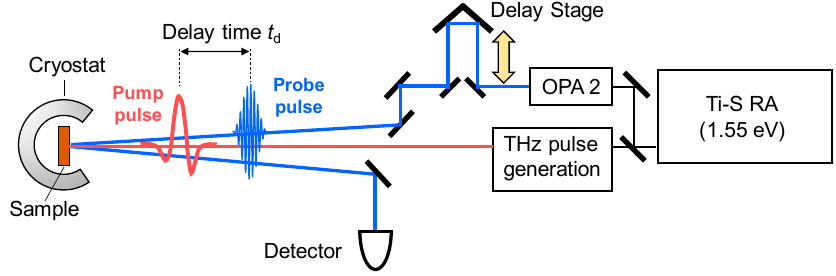
Figure 10. Schematic of terahertz-pump optical-reflectivity-probe measurement system. A terahertz-pump pulse is generated by a pulse-front-tilting method in a LiNbO 3 crystal. Ti-S RA: Ti-sapphire regenerative amplifier; OPA: optical parametric amplifier.